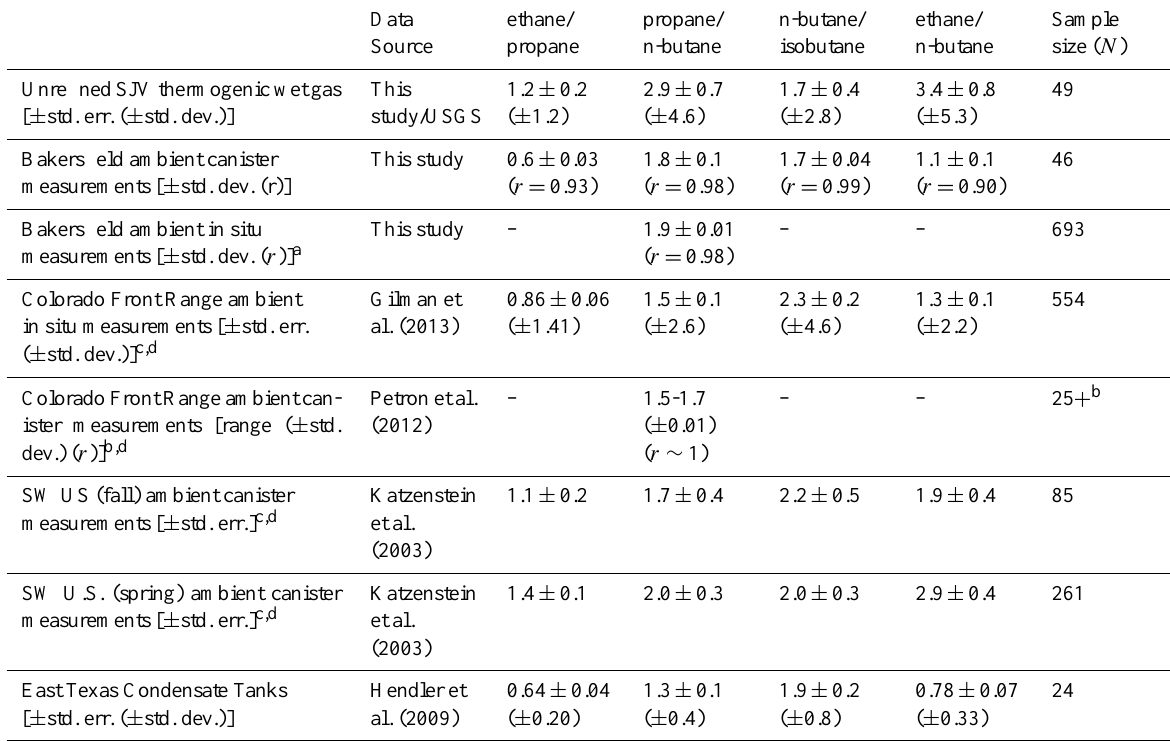
Table 3. Observed light alkane ratios (gCgC − 1 ) from this and other studies.